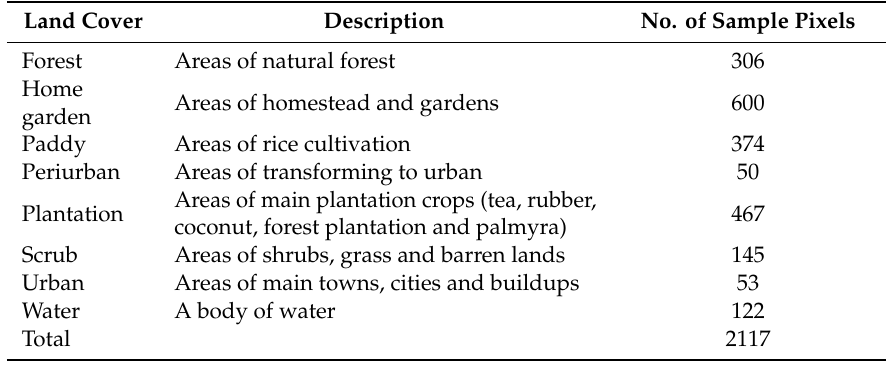
Table 2. Distribution of sample pixels according to different land cover classes.